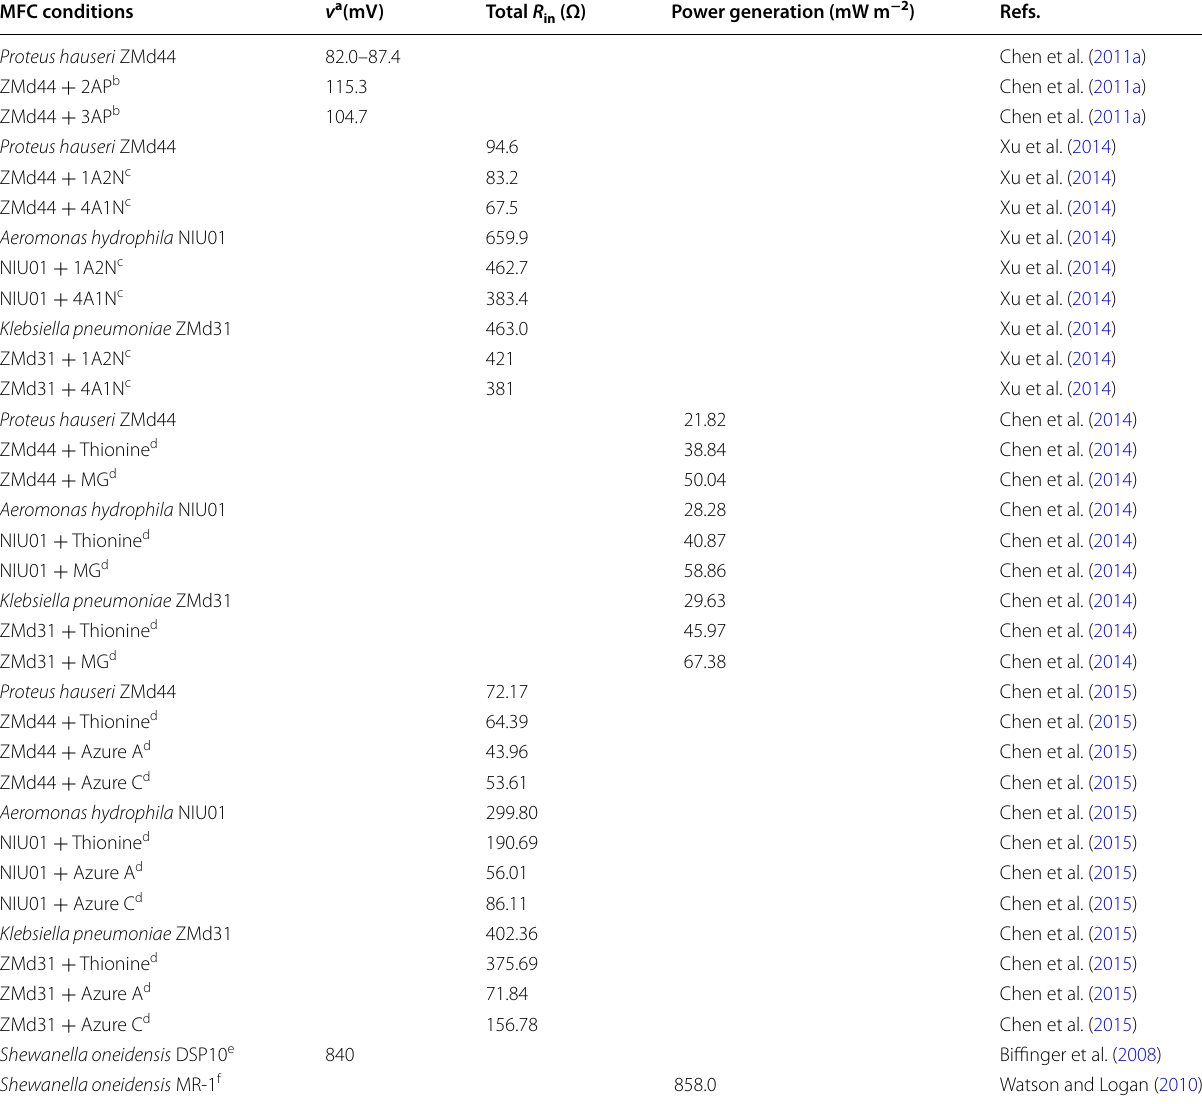
Table 2 Comparisons between Proteus hauseri and other electroactive bacteria on electron transport efficiency in differ‑ ent MFC